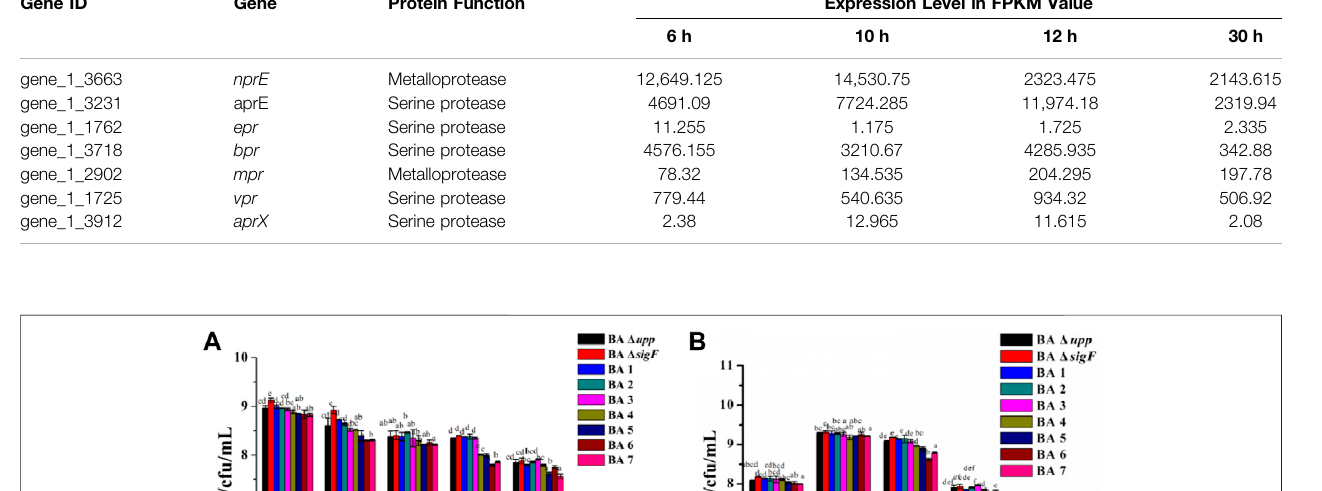
TABLE 3 | Relative expression level of the seven major extracellular proteases of B. amyloliquefaciens TCCC11018 during the entirety of each growth phase. Gene ID